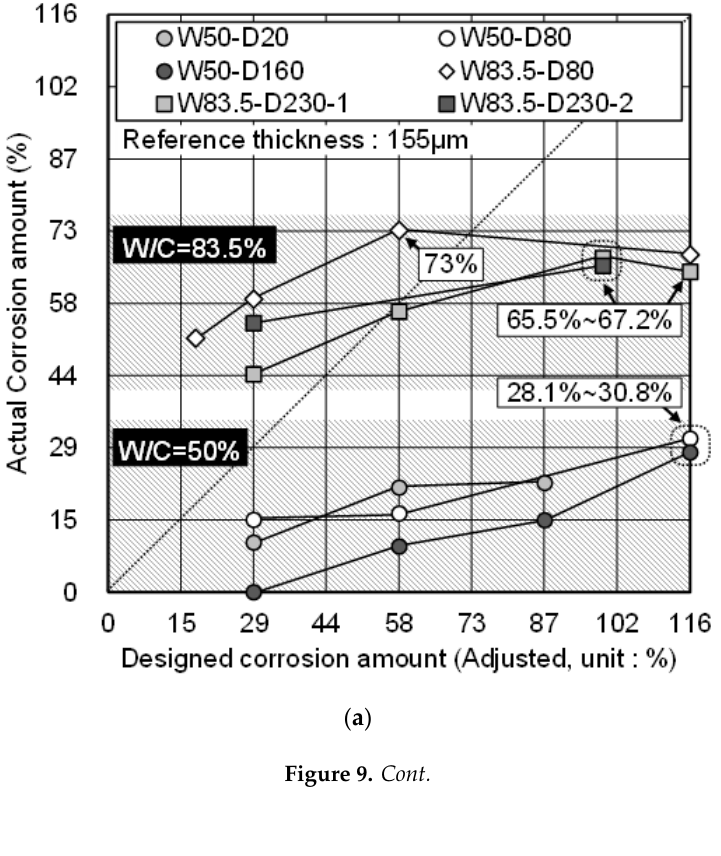
Figure 8. Remaining thickness of the zinc coating.